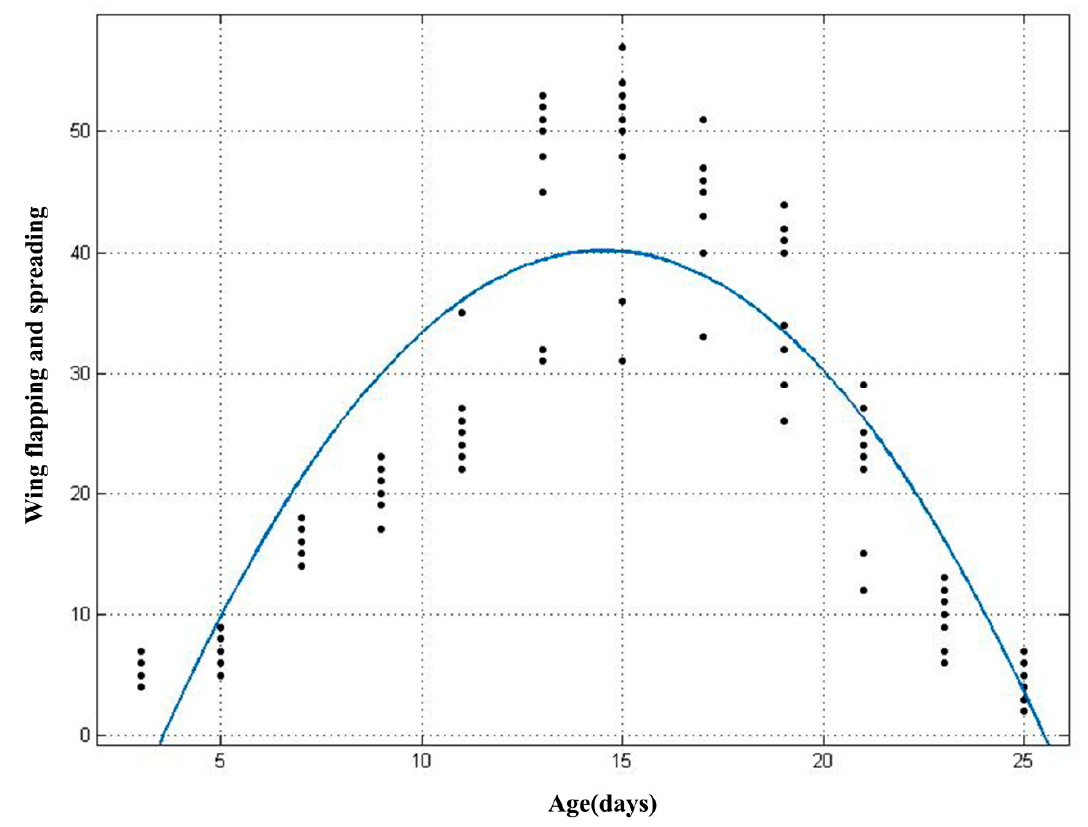
Figure 7. Fitting graph of age and the number of occurrences of wing spreading and flapping behaviours in young Asian parti-coloured bats ( Vespertilio sinensis ).